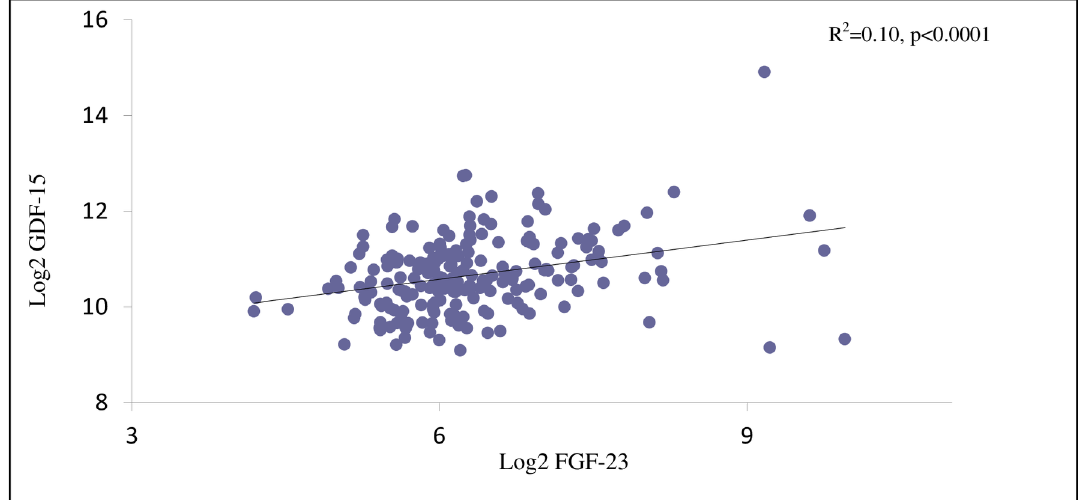
Fig 1. Scatterplot illustrating the significant correlation between log2-transformed GDF-15 and FGF-23 concentrations.